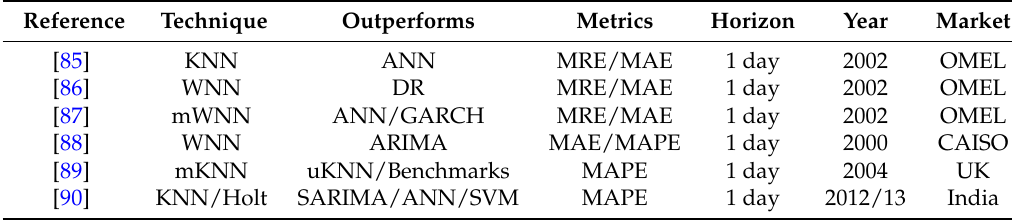
Table 5. Summary on k nearest neighbors (KNN) methods for electricity